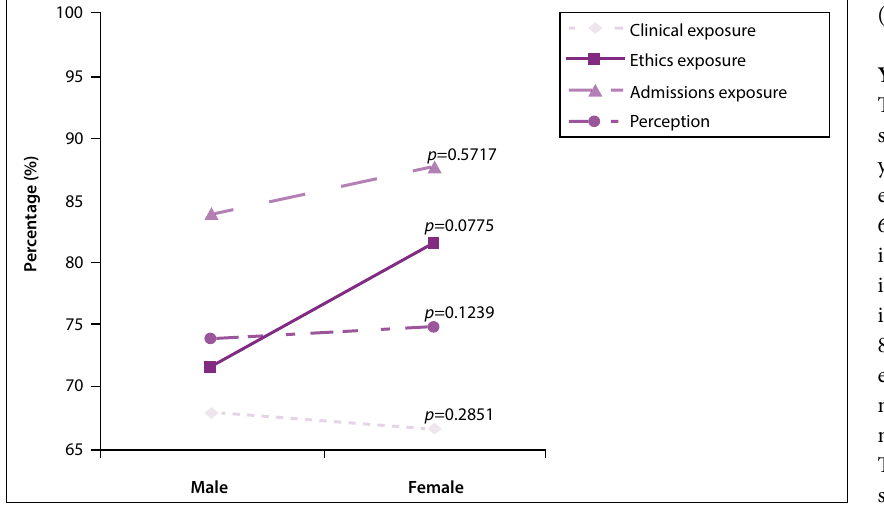
Fig. 5. Scores by gender as a percentage. (No statistically significant differences between the two